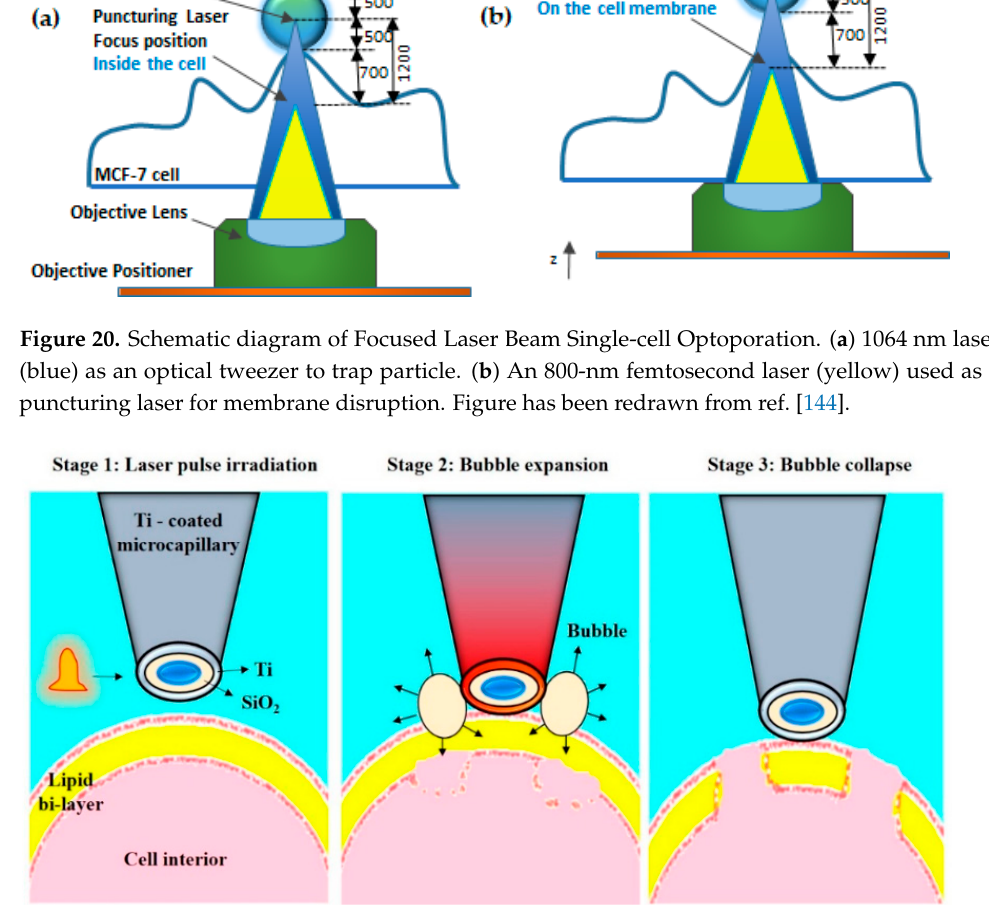
Figure 22. Schematic diagram of the experimental setup for single-cell optoporation. Gold nano- particles are markers of the live cell membrane position which enhances local pulsed-laser opto- poration. Figure has been redrawn from ref. [147]. Copyright © 2020 Royal Society of Chemistry. 3.4. Sonoporation Sonoporation is a physical approach of membrane disruption, in which an ultra- sound is applied in the presence of microbubbles that acts as cavitation nuclei, which forces the cell membrane resulting in disruption and the creation of transient membrane pores to allow biomolecules into the cell [148]. The sonoporation includes ultrasound con- trast agents, to allow the delivery of cargo molecules into cells. It is a transient and reversi- ble phenomenon that obtains high efficiency as well as high cell viability. A critical limi- tation of sonoporation is gene delivery, where ultrasound parameters need to be opti- mized to obtain high gene transfection efficiency and to maintain good cell viability [149]. Sonoporation is primarily performed for the bulk treatment of large cell numbers in vitro or tissue volume in vivo. It is facilitated by microbubbles that are either injected in